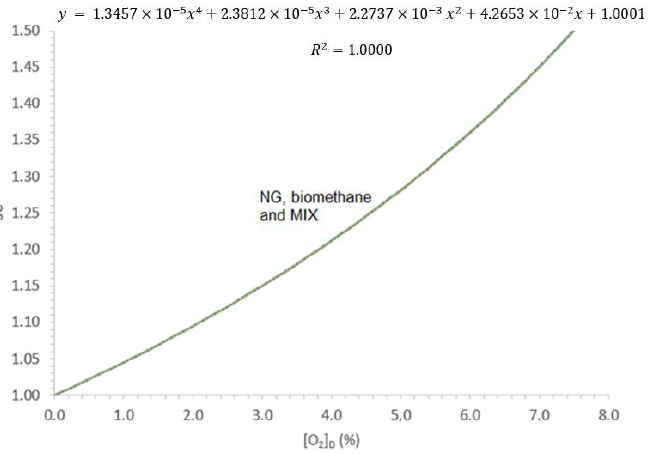
Figure 3. Normalized excess of air (SC) as function of the oxygen concentration in dry basis.